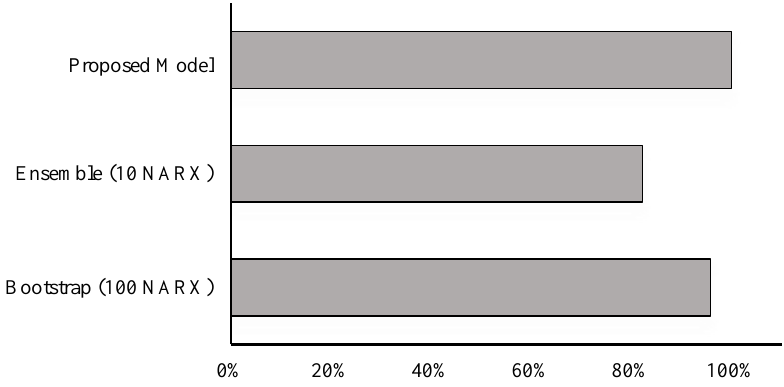
Figure 13. Benchmarking the proposed model, in terms of prediction interval coverage probability (PICP) (%), at 3-step-ahead predictions.